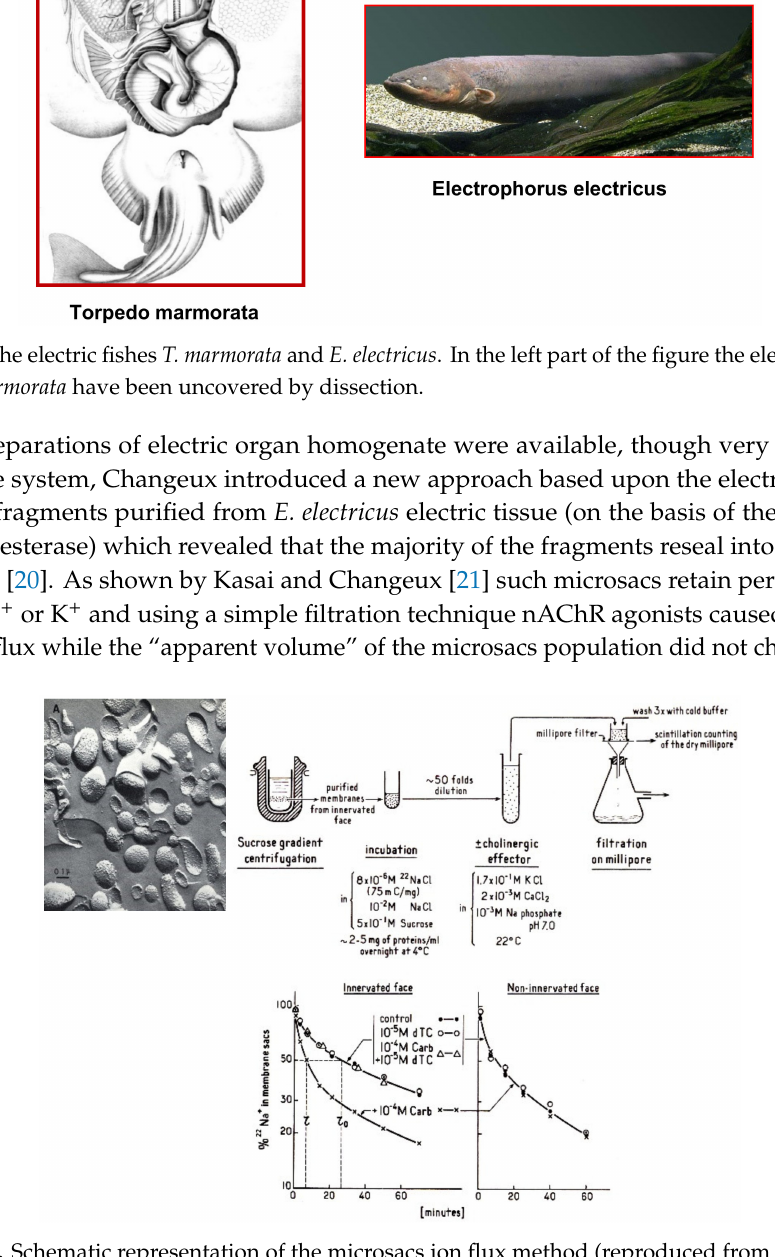
Figure 3. Schematic representation of the microsacs ion flux method (reproduced from Ref